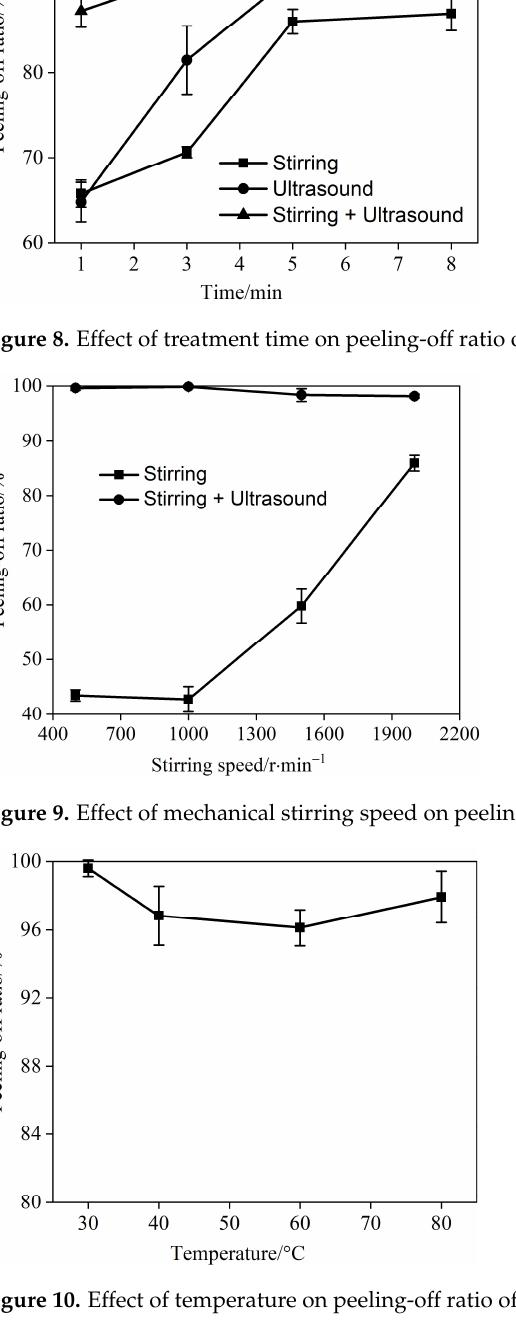
Figure 10. Effect of temperature on peeling-off ratio of ultrasound-mechanical stirrer. 3.4. XRD, XRF, and SEM Analysis of Liberated Graphite Electrode Material Figure 11 presents the comparative XRD pa(cid:308)erns for the fresh graphite material in its pristine state and the spent LIB graphite material liberated from Cu foil. The XRD pat- tern of the fresh graphite material is taken from the literature [51]. The XRD analysis showed high-intensity peaks near 26.5, consistent with the XRD pa(cid:308)ern of standard